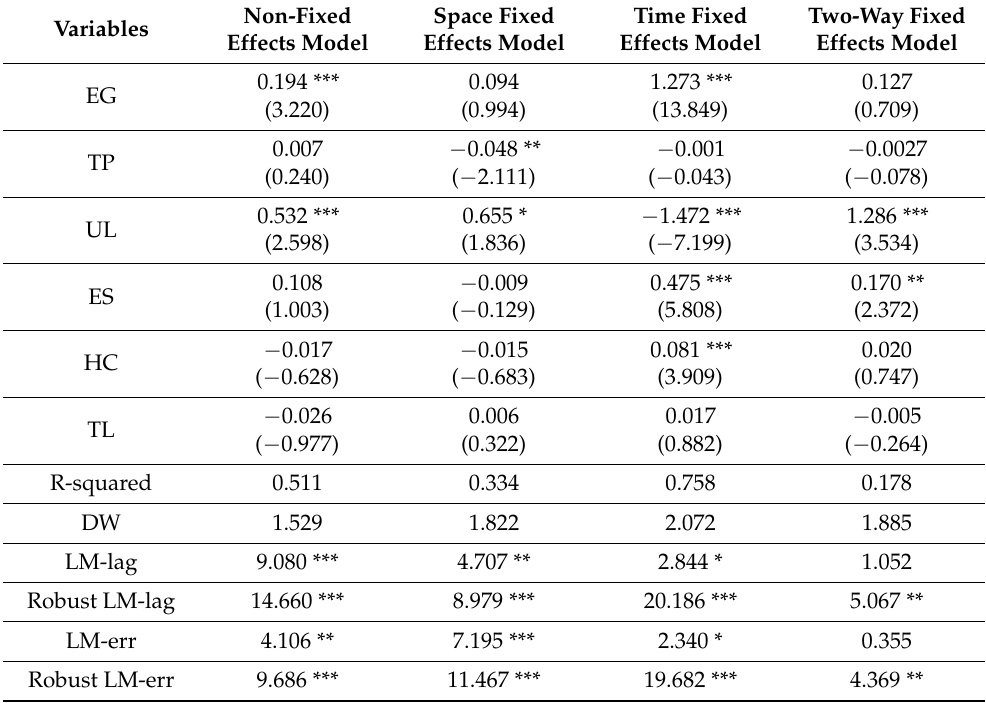
Table 4. The estimation and test results of different fixed-effects